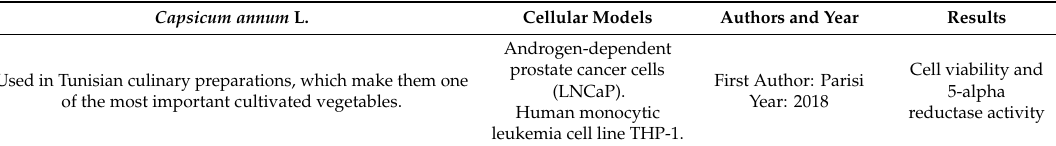
Table 7. Schematic representation of in vitro cellular models used to test the role of Capsicum annum L. Capsicum annum L. Used in Tunisian culinary preparations, which make them one of the most important cultivated